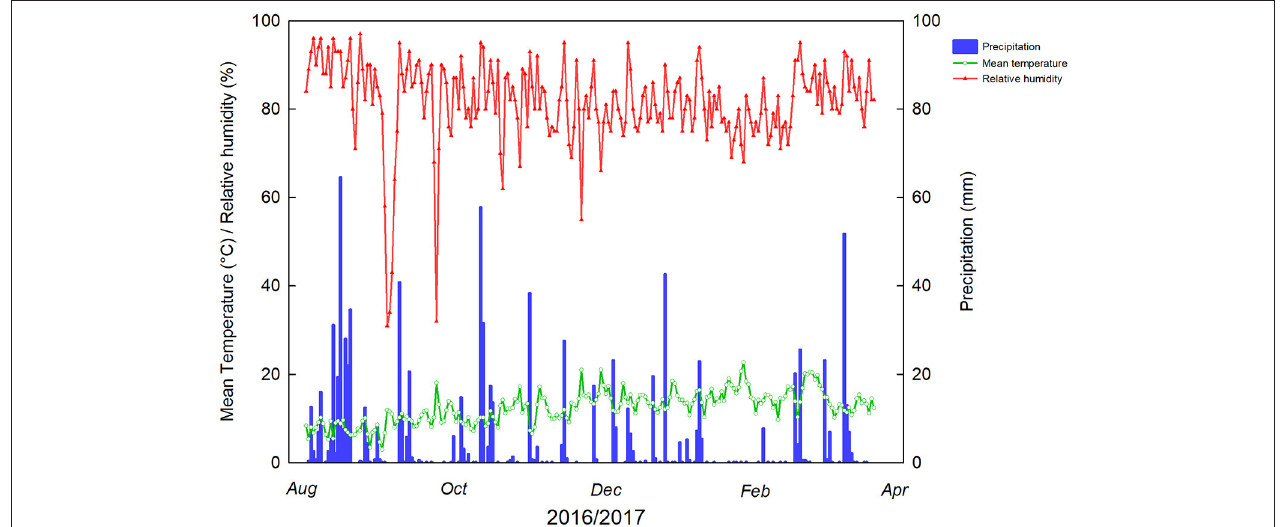
FIGURE 1 | Weather parameters during the hazelnut vegetative season at the experimental site, Caracas Farm, Cunco (39 ◦ 00 ′ S, 72 ◦ 31 ′ W), La Araucanía region, Chile. Minimum and maximum temperatures were − 4.5 ◦ C (9/1/2016) and 34.6 ◦ C (1/26/17) during the studied period.